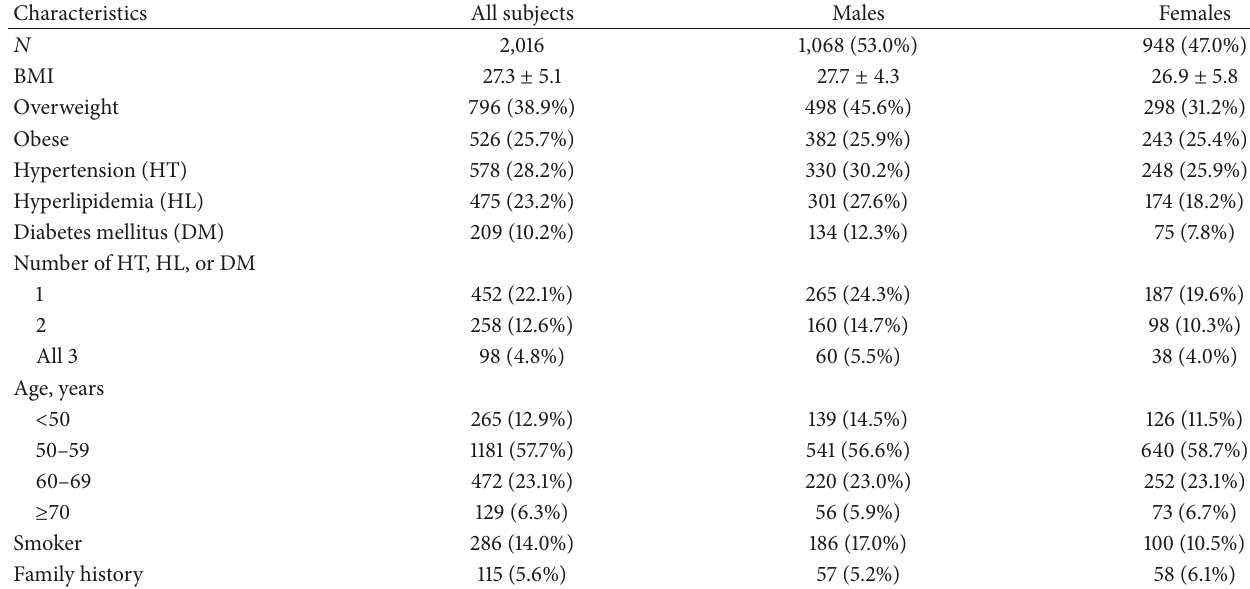
Table 1: Participant characteristics; mean ± SD or 𝑛 (%). Smoker defined as current consumption of any amount of tobacco. Family history defined as presence of at least one first-degree relative with CRC aged 60 or under.